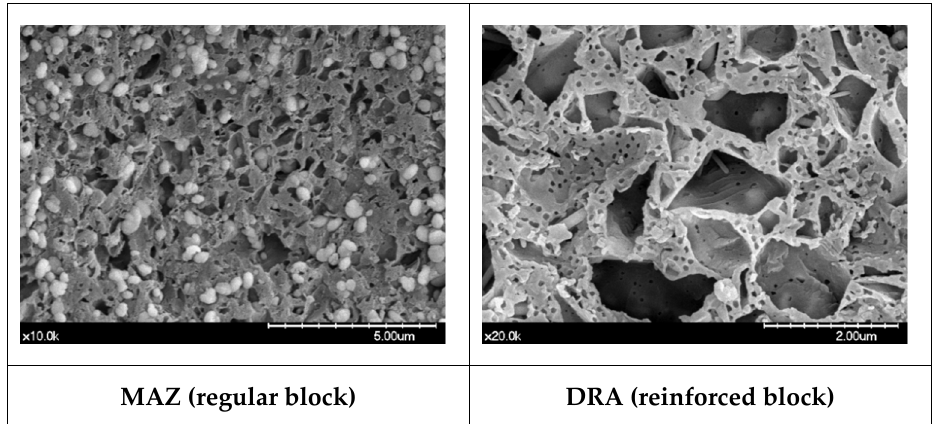
Figure 2. Microstructures of hybrid composite blocks after 30% HF solution treatment (top = original magnification 10k, bottom = original magnification 20k, left = the regular block, right = the reinforced block).